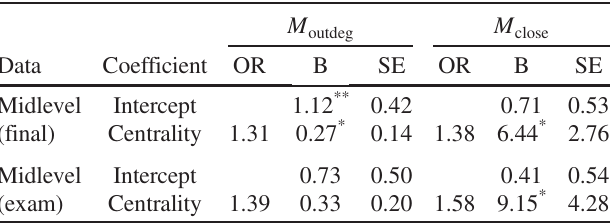
TABLE VII. Model verification without grade. Odds ratio (OR), estimates (B), and standard error (SE) for simple logistic regression models for persistence as predicted by out-of-class outdegree ( M ; columns 3 – 5) and out-of-class closeness outdeg ( M ; columns 6 – 8). We consider two cases to test our modes: close (1) the intermediate grades category based on final grades ( N ¼ 90 ); (2) the intermediate grades category based on midterm scores ( N ¼ 47 ). Significant P values are marked with an asterisk. M M outdeg